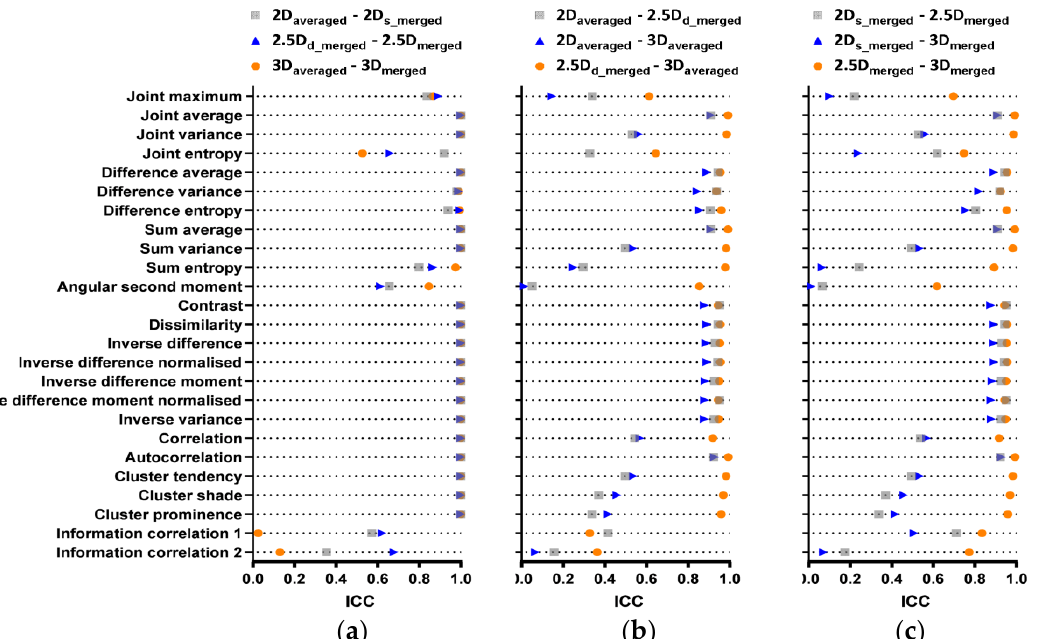
Figure 2. Pairwise ICC for each GLCM feature extracted from: ( a ) 2D averaged -2D s_merged , 2.5D d_merged -2.5D merged , 3D averaged -3D merged , ( b ) 2D averaged -2.5D d_merged, 2D averaged -2.5D merged , 2.5D d_merged - 3D averaged , ( c ) 2D s_merged -2.5D merged , 2D s_merged -3D merged , and 2.5D merged -3D merged